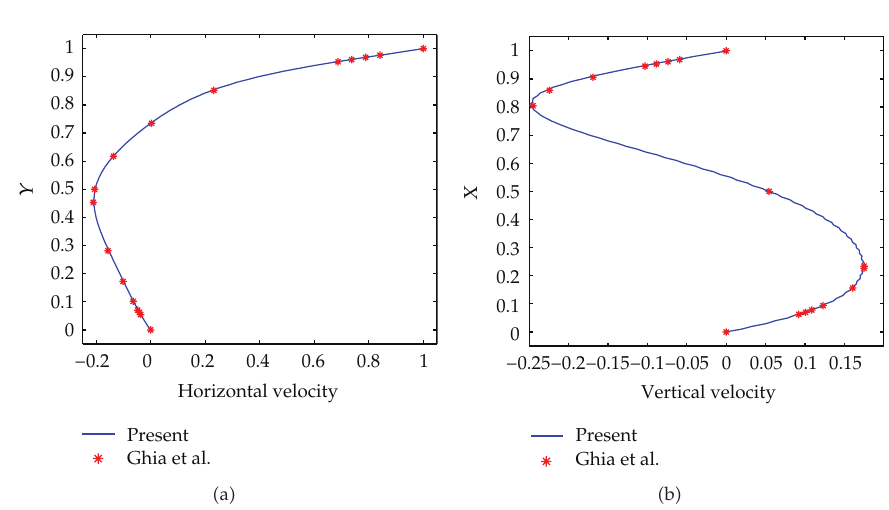
Figure 4: The computed velocity profiles through the geometric center at Re (cid:10) 100. (cid:4) a (cid:5) Horizontal velocity, (cid:4) b (cid:5) vertical